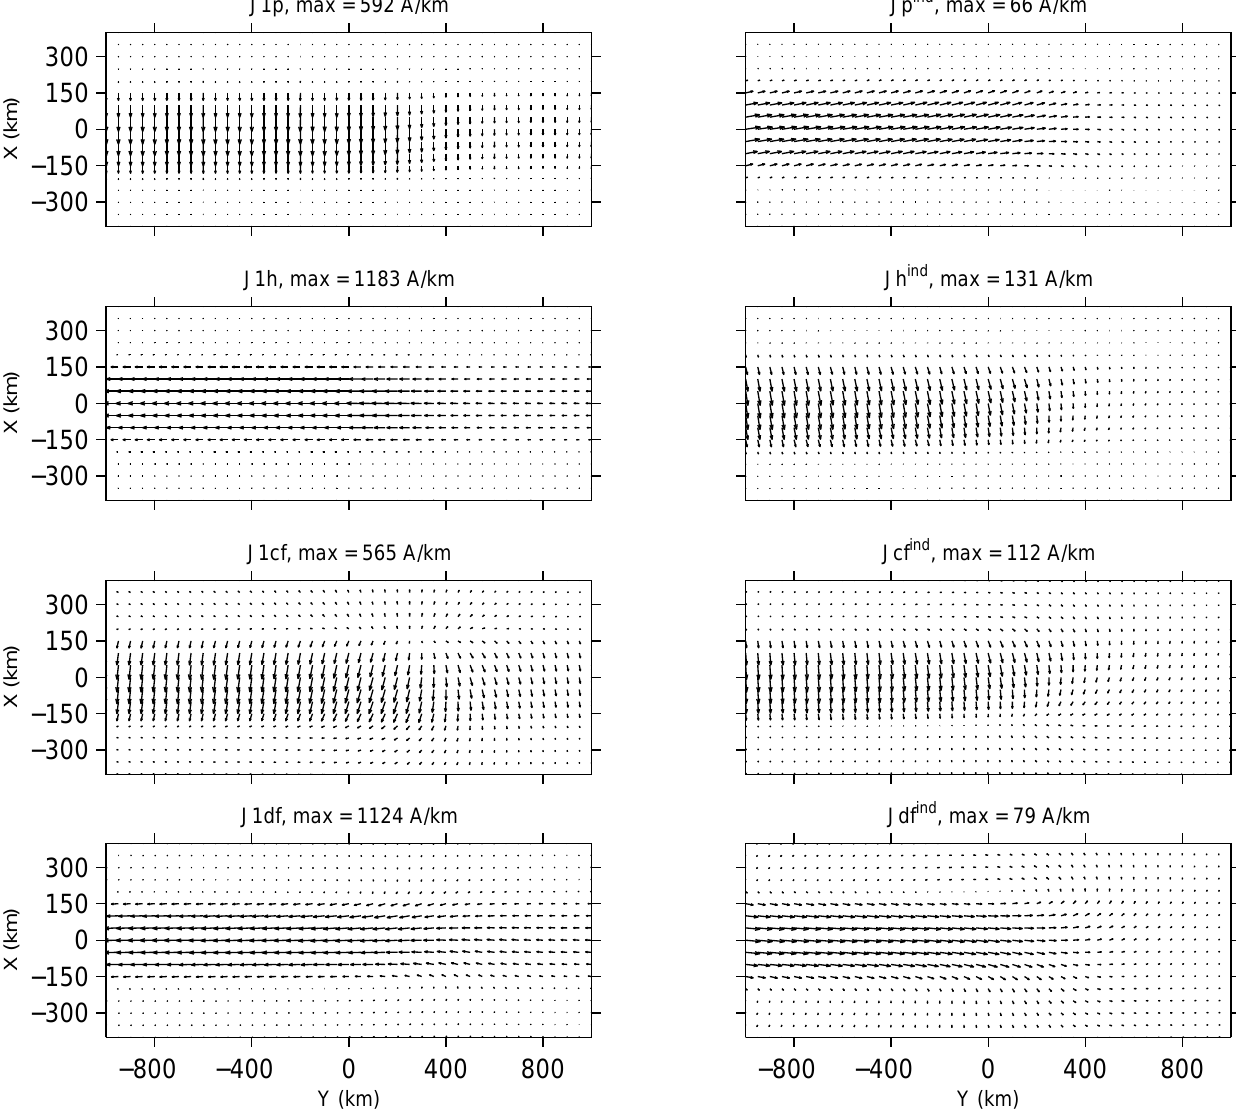
Fig. 6. The division of original (1) and induced (ind) currents of the electrojet model into Pedersen (Jp), Hall (Jh), curl-free (Jcf) and divergence-free (Jdf) parts at time instant t =